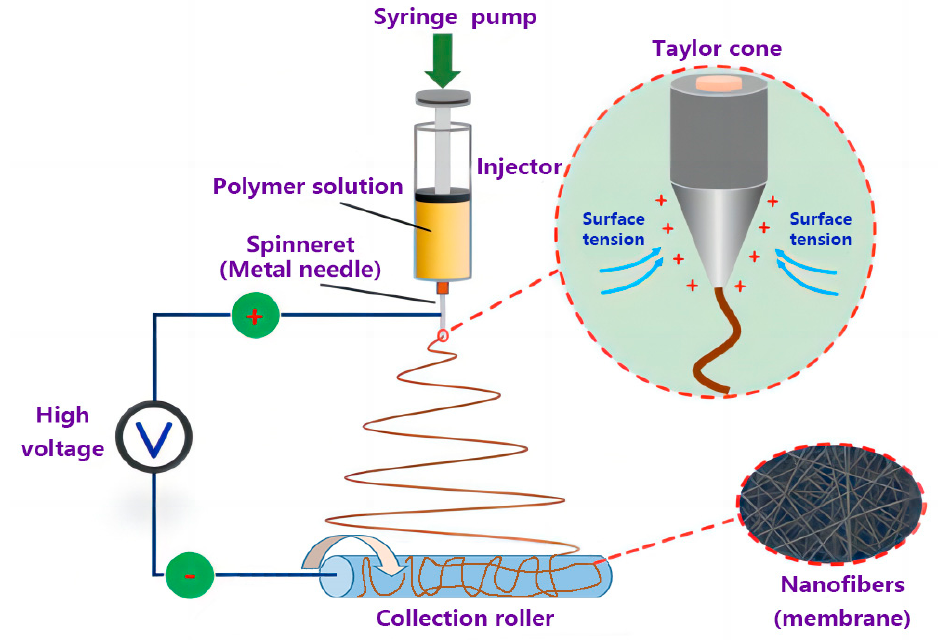
Figure 1. The electrospinning device.